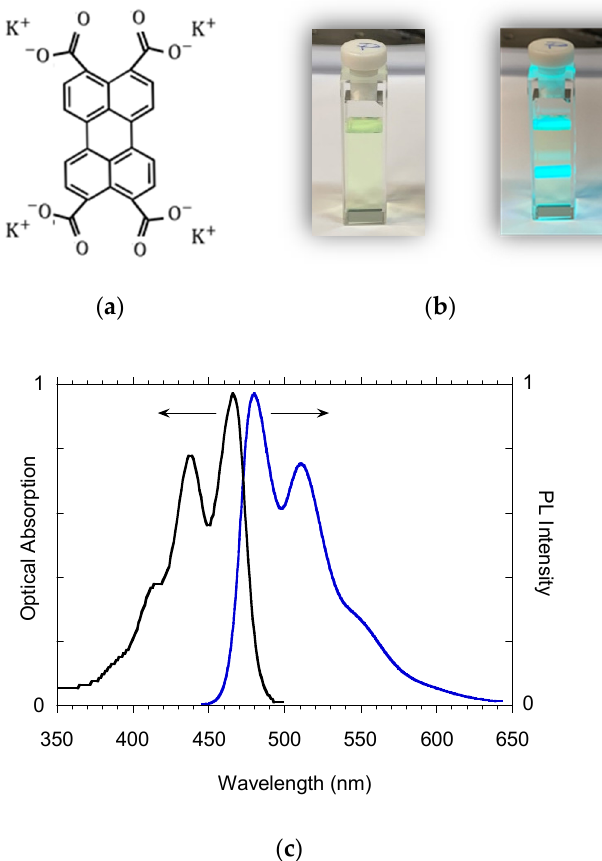
Figure 2. ( a ) PTAS chemical structure; ( b ) pictures of a PTAS water solution (c = 4 µ M) in ambient light (left) and under excitation with a laser beam 408 nm (right); ( c ) absorption and emission spectra of PTAS in water (c = 4 M).